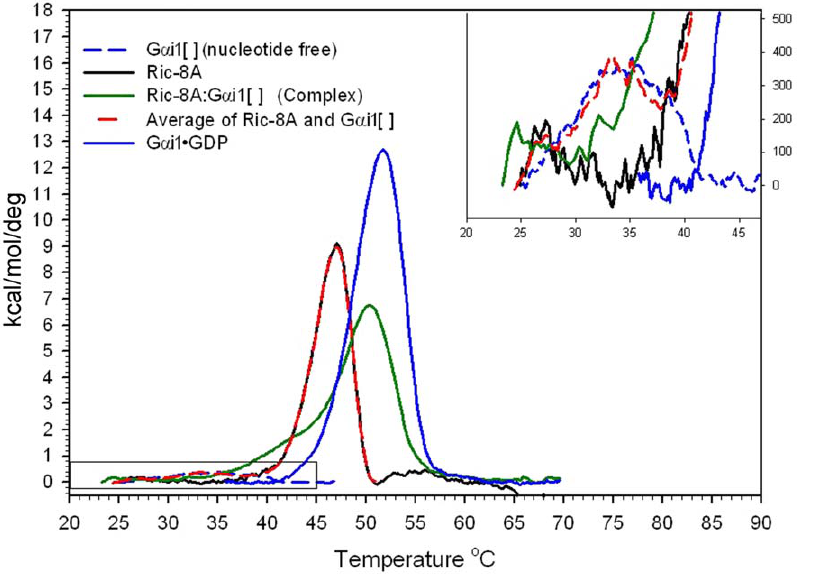
Figure 7. Thermal denaturation properties of G a i1 and Ric-8A are affected by their mutual interaction. Temperature-dependence of heat capacity was measured by differential scanning calorimetry. Buffer baseline-corrected thermograms were recorded for Ric-8A (black trace), G a i1 [ ] (dashed blue trace), G a i1 N GDP (blue trace) and Ric-8A:G a i1[ ] (green trace). The weighted average of the thermograms for Ric-8A and G a i1[ ] (red dashed line) overlaps that of G a i1[ ] in the temperature range below , 37 u C and that of Ric-8A above that temperature, and is distinct from the thermogram of Ric-8A:G a i1[ ]. The inset shows a magnified view of the four thermograms and the weighted average function in the 20 u C–45 u C range.